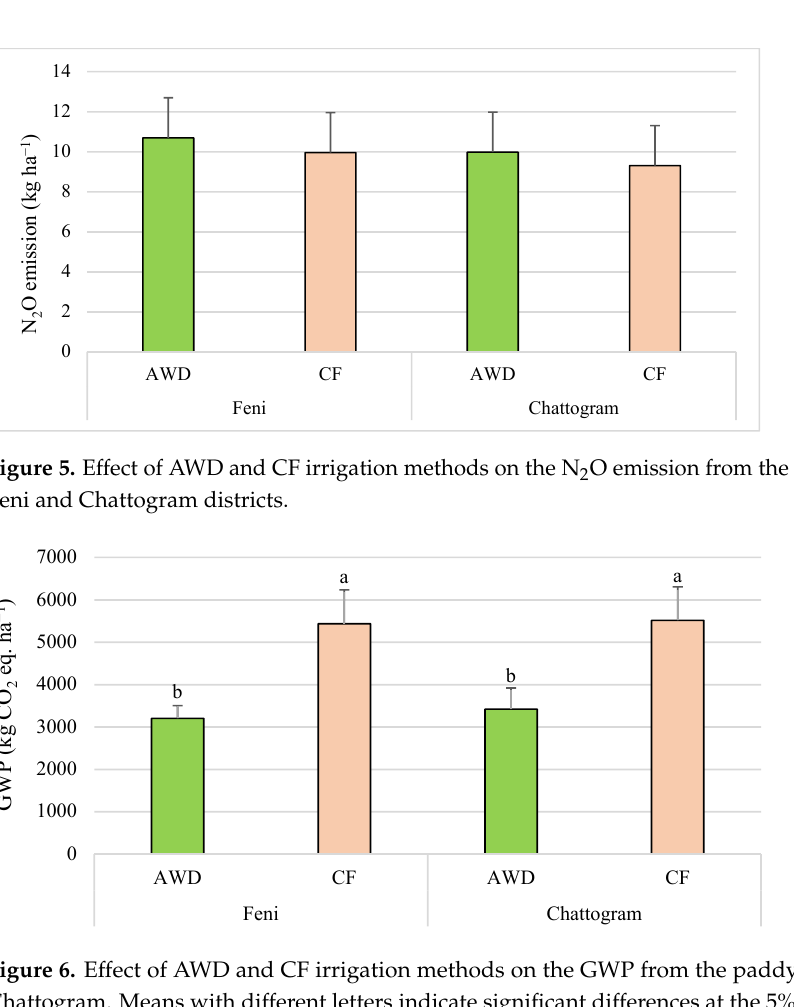
Figure 6. Effect of AWD and CF irrigation methods on the GWP from the paddy field at Feni and Chattogram. Means with different letters indicate significant differences at the 5% level.